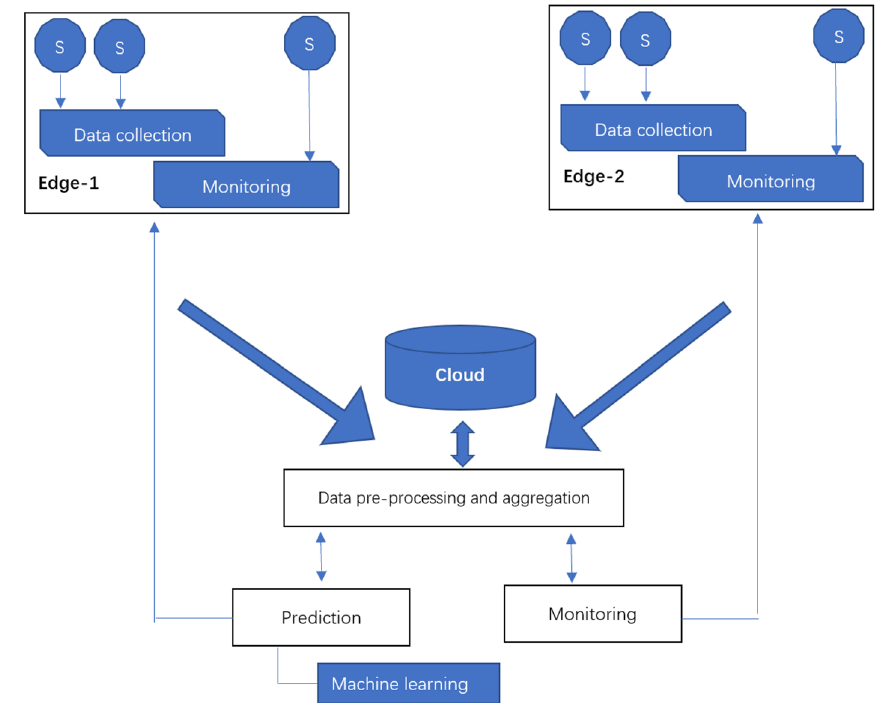
Fig. 10 Framework for real-time prediction and monitoring of